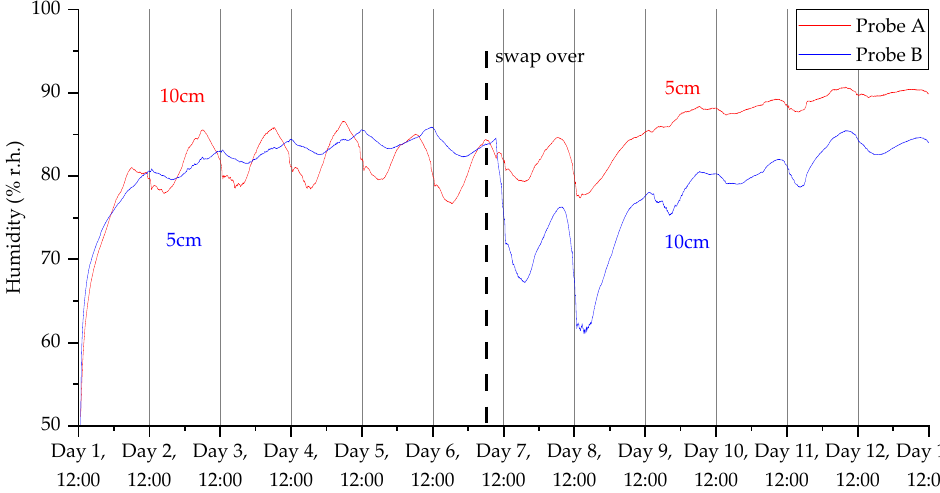
Figure 14. Humidity measurements for the 2nd deployment in Wellesbourne campus woodland. Data collection commenced on 12 July 2022 at 12:45 (24 h time).